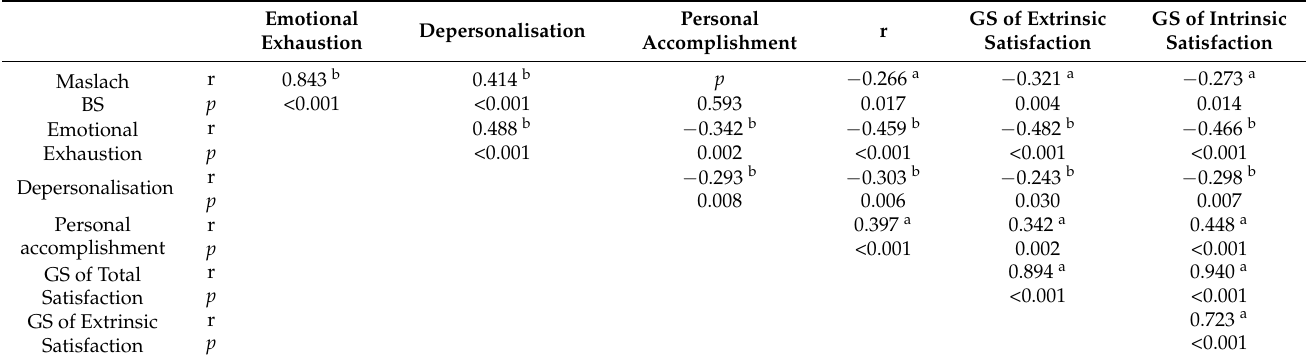
Table 4. Correlation between burnout syndrome and job